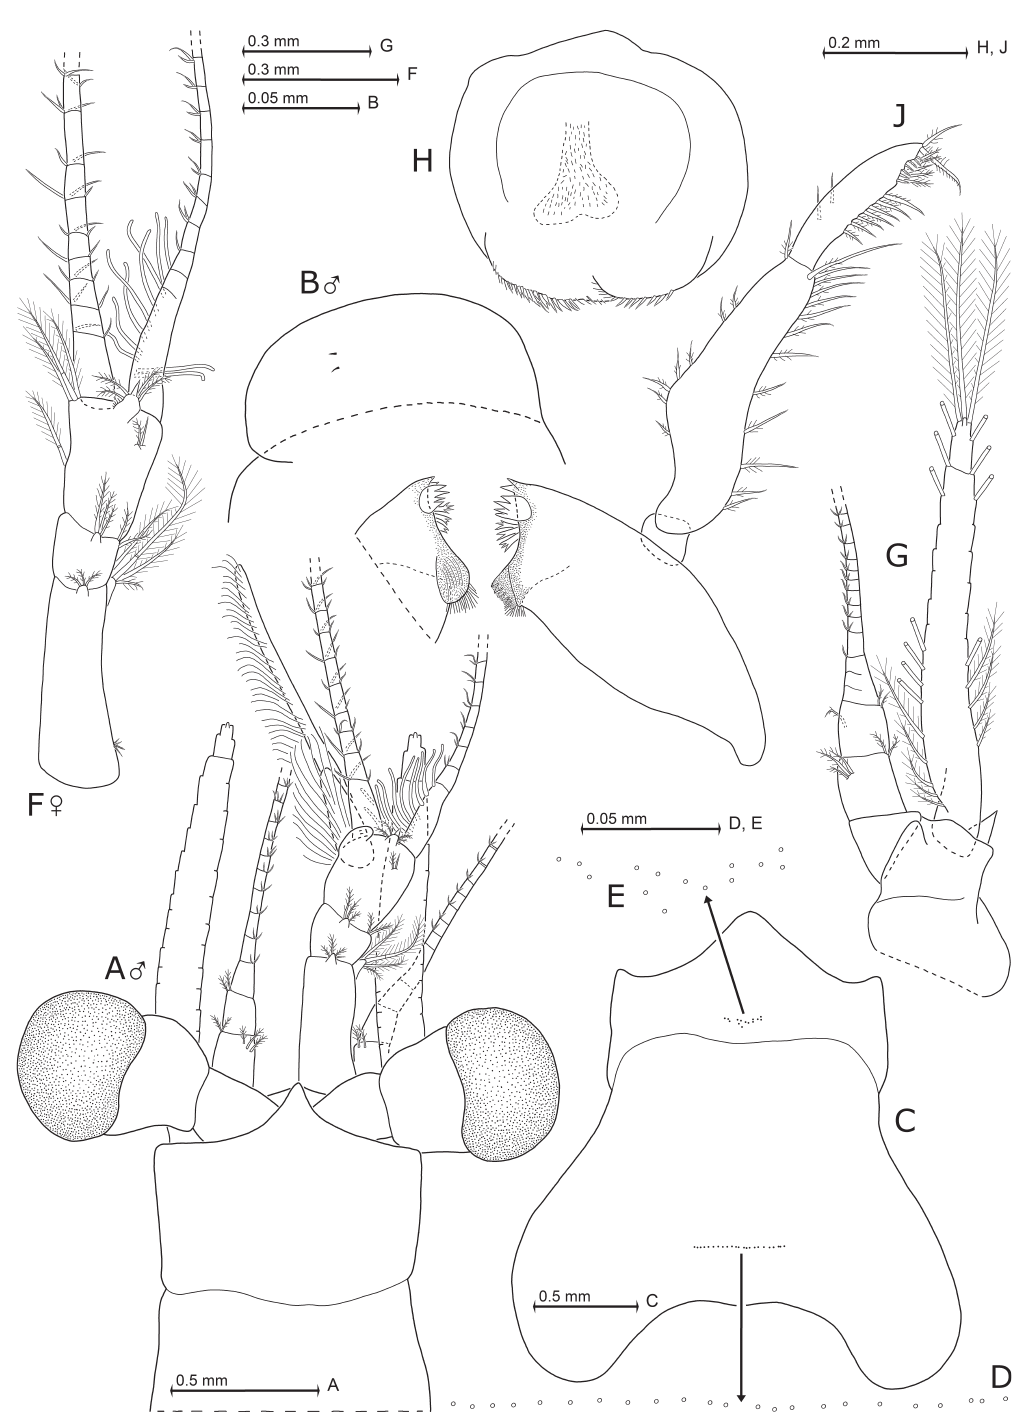
Fig. 10. Mysidium antillarum Wittmann sp. nov., from Curaçao, holotype (A) and paratypes (B–J). A . ♂, 7.3 mm body length. B . ♂, 7.5 mm. C–E, H . ♀, 7.9 mm. F . ♀, 7.5 mm. G, J . ♂, 6.4 mm. A . Cephalic region; left antennula and setae of antennal scale omitted. B . Mediodistal extension of left antennular trunk, dorsal view. C . Carapace expanded on slide. D – E . Details of panel (C) showing cardial (D) and cervical (E) pore groups; pore diameters not to scale. F . Right antennula of female, dorsal view. G . Right antenna, dorsal view. H . Labrum, ventral view. J . Left mandible with right masticatory process, caudal